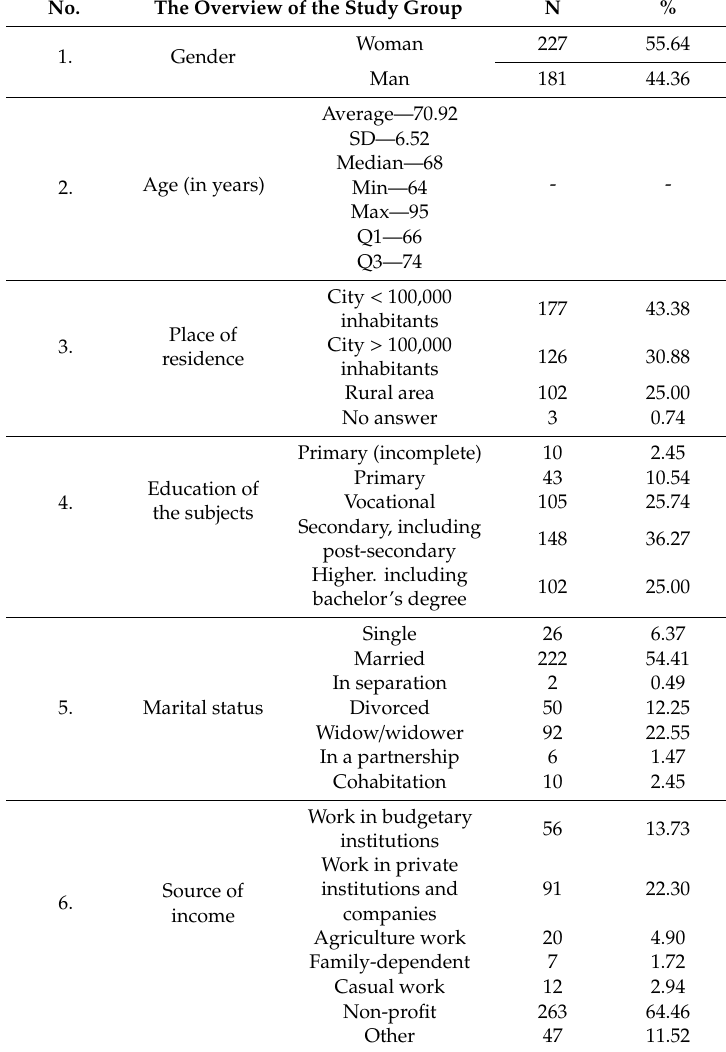
Table 1. The overview of the study